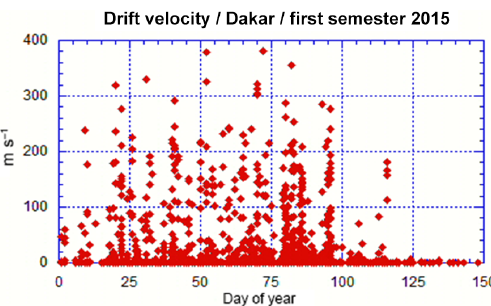
Figure 5. Ratio of intensity to phase scintillation indices in Dakar in 2015.